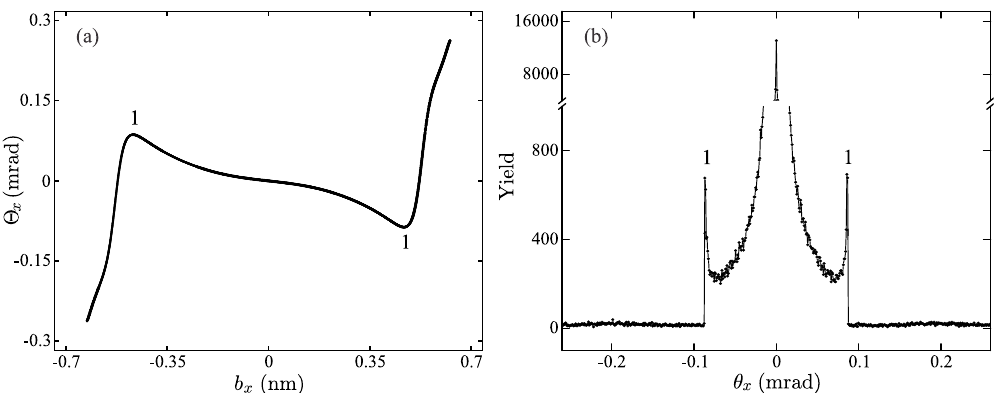
Figure 4. ( a ) Angular transmission function Θ x ( b ) of 1-GeV protons transmitted through 10 µ m long SWCNT (11,9). ( b ) The vertical slice through the corresponding angular distribution. All rainbow points are numbered, equivalent rainbow points are designated by the same